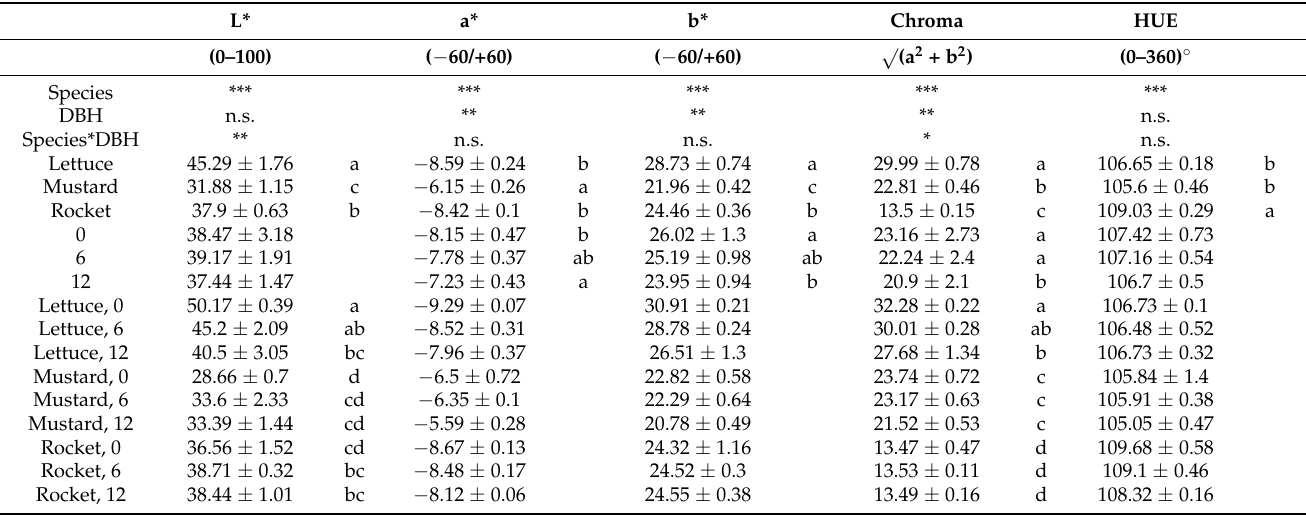
Table 2. Canopy colorimetric attributes of three microgreen species (lettuce, mustard, rocket) in response to nutrient deprivation treatment (DBH) applied for 6 or 12 days before harvest. All data are expressed as mean ± standard error, n =